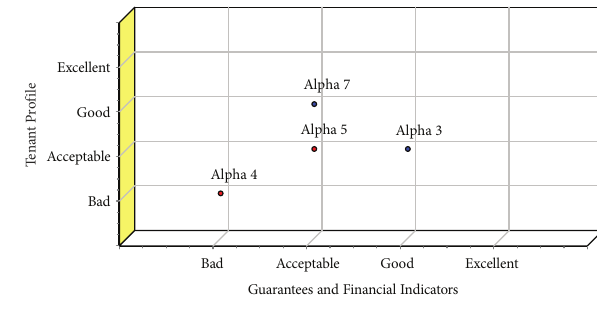
Figure 12. Scatter/dominance